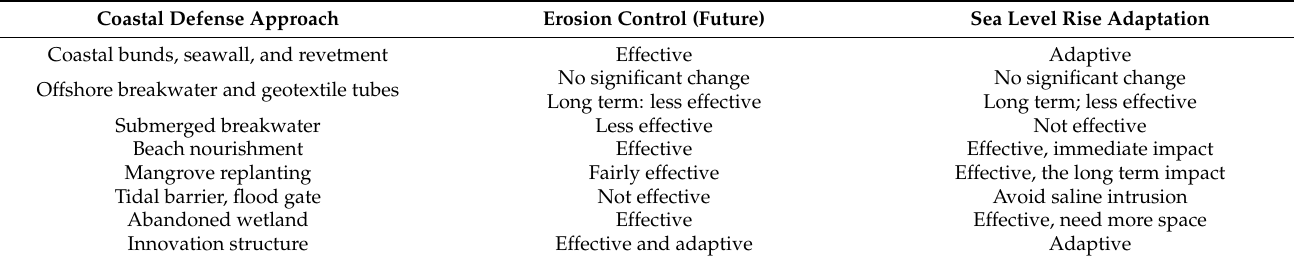
Table 5. Summary of coastal structures as erosion control and sea-level rise adaptation. Coastal Defense